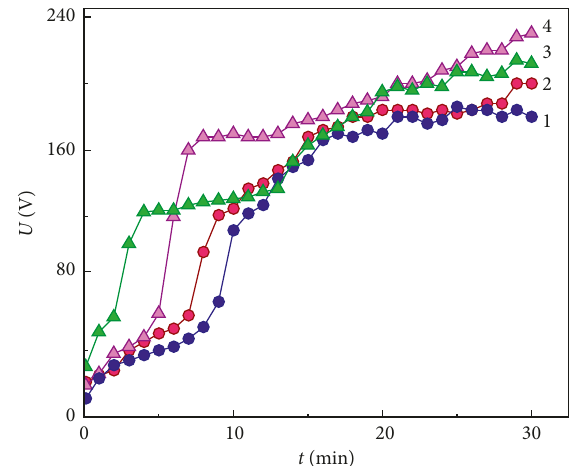
Figure 1: Chronograms of the forming voltage at PEO with current density 2A/dm 2 for oxide coatings. 1: TiO x TiO x WO y ; 4: TiO x ZrO 2 · ·